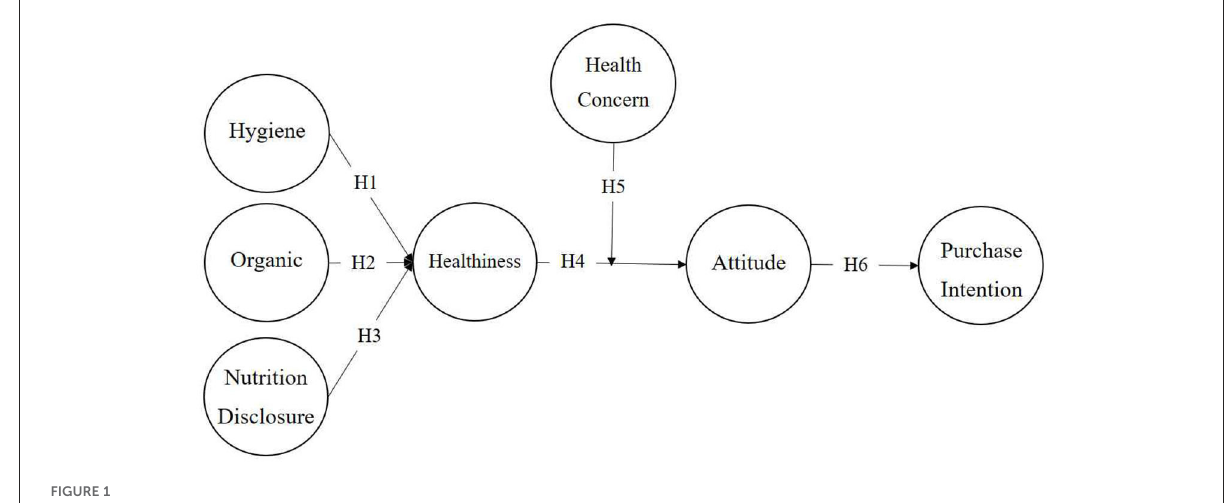
FIGURE1 Research model.